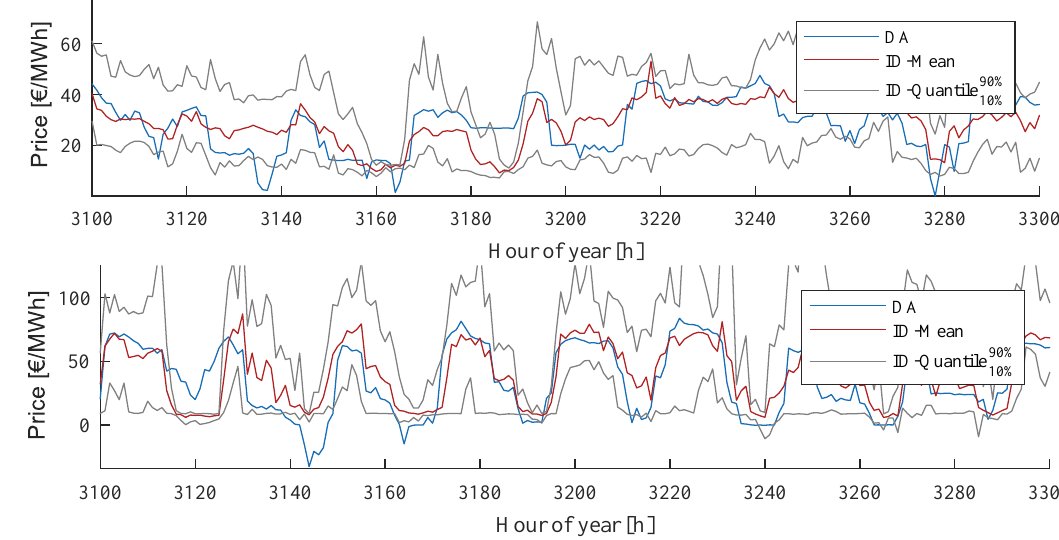
Figure A4. Excerpt of DA and ID electricity price time series for 2023 ( top ) and 2035 ( bottom ).